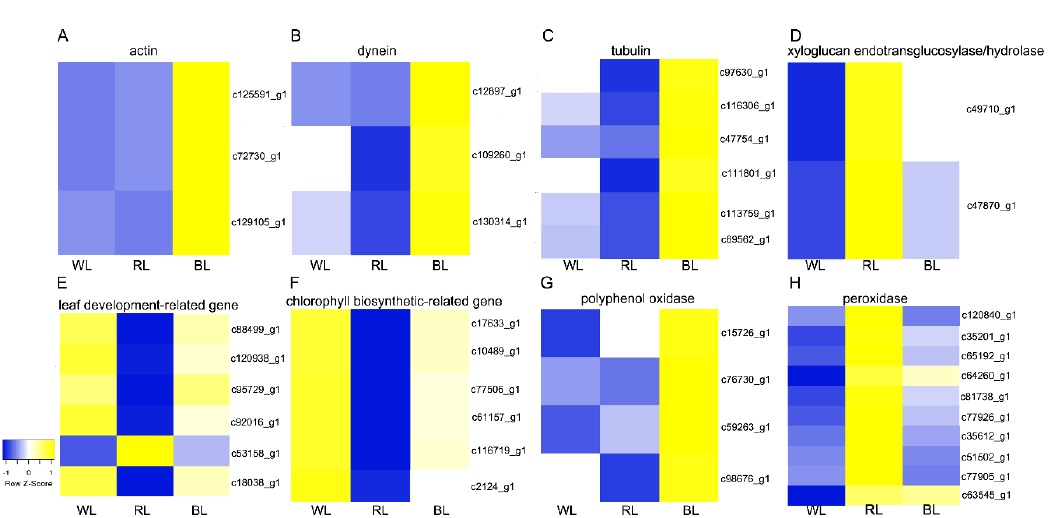
Figure 9. Expression profile of some genes in C. oleifera leaves under di ff erent light conditions. ( A ) Actin. ( B ) Dynein. ( C ) Tubulin. ( D ) Xyloglucan endotransglucosylase / hydrolase. ( E ) Leaf development-related gene. c88499_g1 represents an uncharacterized protein; c120938_g1 and c95729_g1 represent BTB / POZ domain-containing protein DOT3; c92016_g1 represents ARF5; c53158_g1 represents SRK2E; c18038_g1 represents an uncharacterized protein. ( F ) Chlorophyll biosynthetic process. c17633_g1, c10489_g1 and c77506_g1 represent magnesium–chelatase subunit ChlH; c61157_g1 represent geranylgeranyl diphosphate reductase; c116719_g1 and c2124_g1 represent glutamyl–tRNA reductase 1. ( G ) Polyphenol oxidase. ( H ) Peroxidase.